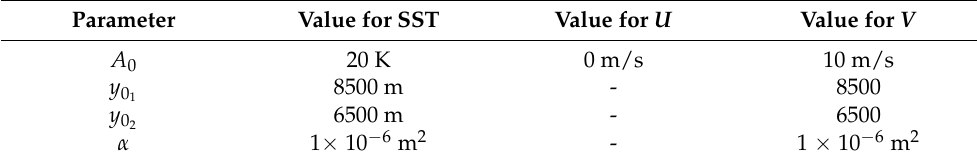
Table 2. Gaussian jet parameters that were used in this study. Parameter Value for SST Value for U Value for V A 0